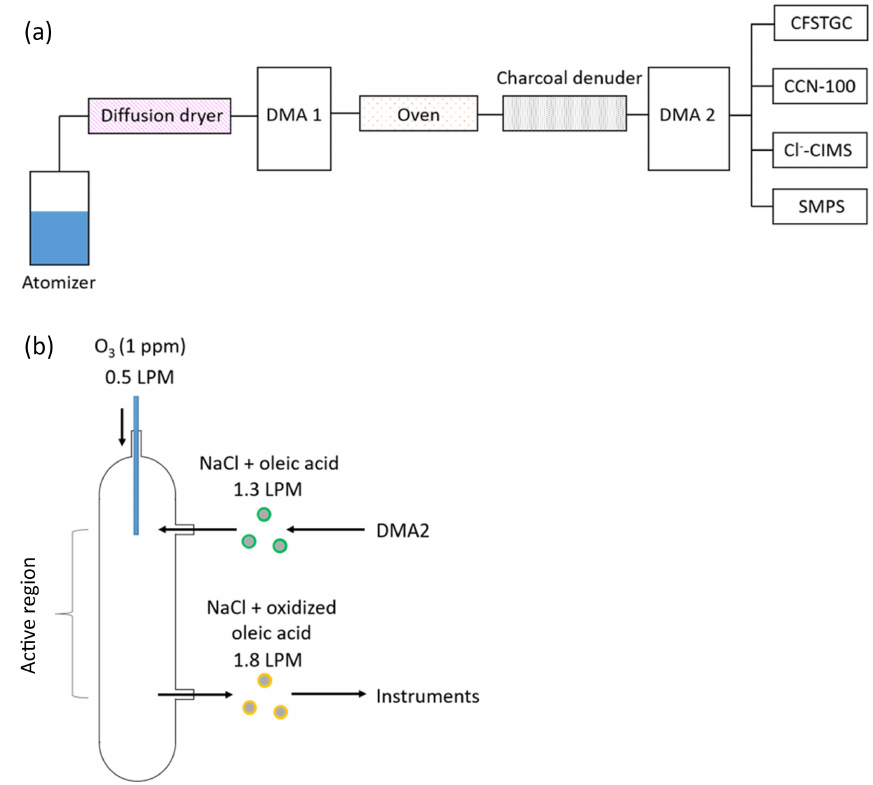
Figure 1. (a) Experimental schematic for non-oxidized experiments. (b) Flow tube schematic for NaCl + oxidized oleic acid experiments. The blue line illustrates the movable